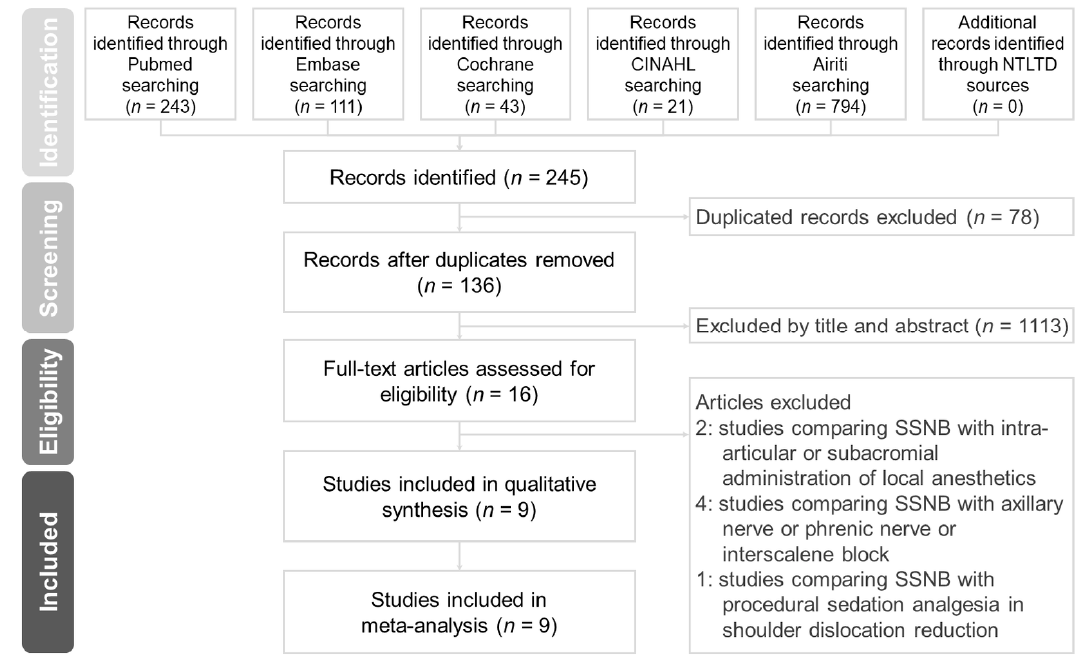
Figure 1. Preferred Reporting Items for Systematic review and Meta-Analysis (PRISMA) flow diagram.